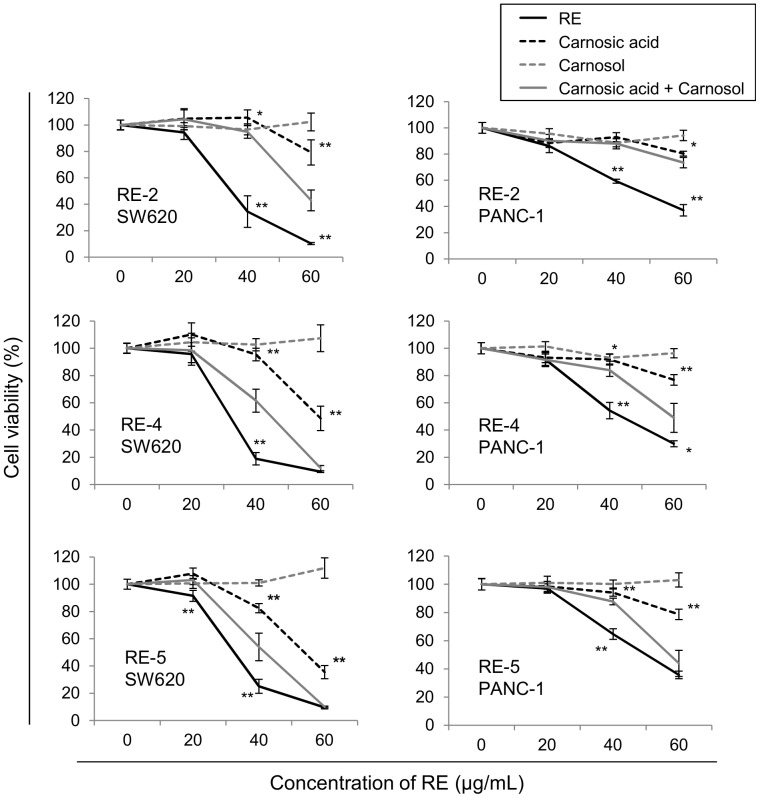
Inhibition of cancer cell viability by different RE's in comparison with their major active components.Cell viability inhibition of cancer cells by different RE's and their equivalent concentrations of carnosic acid alone, carnosol alone, or both compounds in combination. SW620 colon and PANC-1 pancreatic cancer cells were treated with increasing concentrations of RE-2, RE-4 and RE-5, and the same concentrations of carnosic acid, carnosol, and the combination of both present in the RE's at each assayed condition. Extract ID and tumor cell line used in the assay are indicated in each graph. Results are shown as the mean ± SEM of three independent experiments, each performed in quadruplicate. Asterisks indicate statistically significant differences of carnosic acid or extract in comparison with the combination of carnosic acid and carnosol (U de Mann-Whitney; *p≤0.05; **p≤0.01). RE: supercritical rosemary extract.